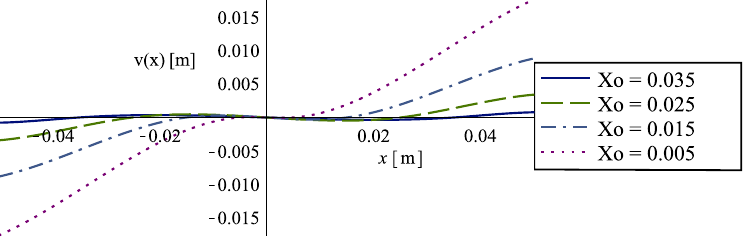
Figure 9. The beam shape for several settings of the support location, x applied force, F . Note the particular beam shape near the ends, caused by clamping the leaf spring in the mechanism